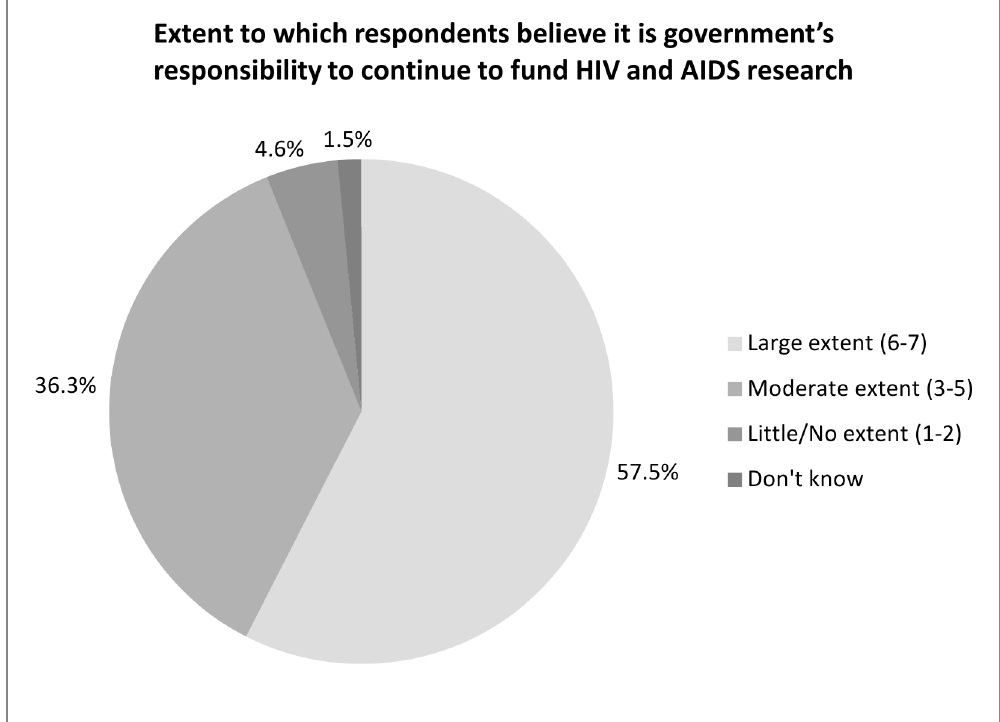
Figure 1. Large extent (6–7). Moderate extent (3–5). Little/No extent (1–2). Don’t know.